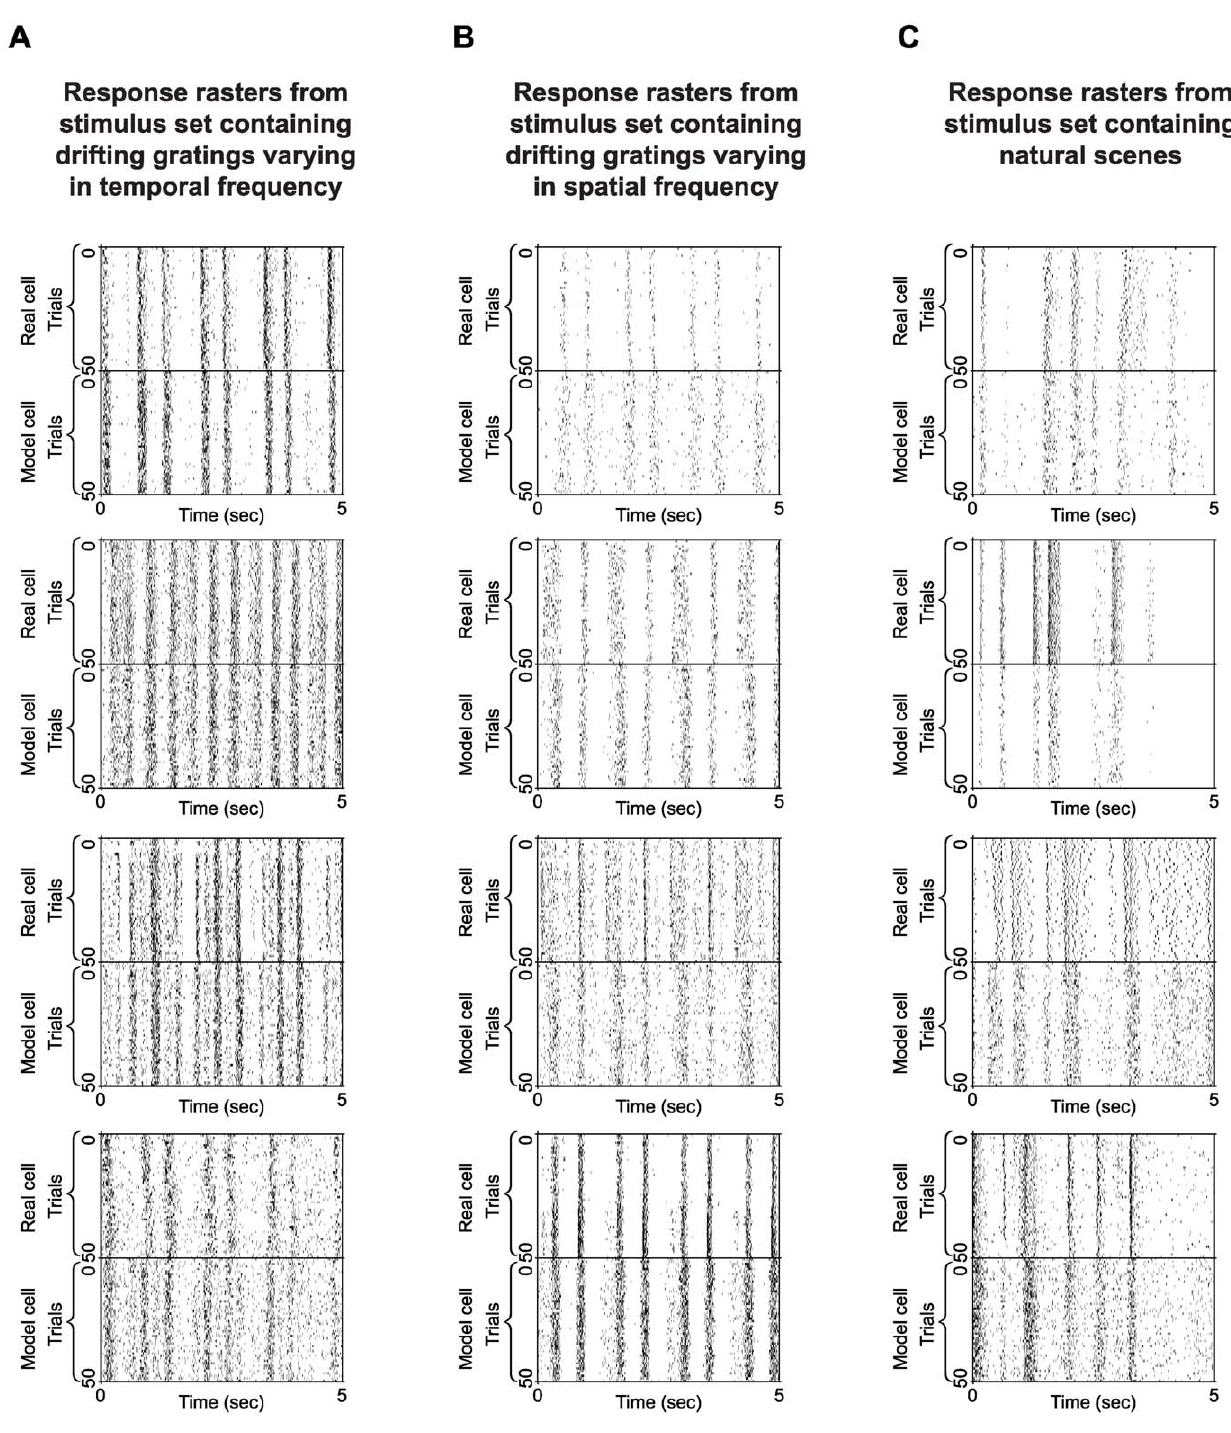
Figure 8. Response rasters for the first 12 cells shown in Fig. 4. Fig. 4 shows real and model cell performance using three sets of stimuli. Here we show rasters of the underlying responses. A . Rasters for the responses to the drifting gratings that varied in temporal frequency. The stimulus is a continuous stream of drifting gratings with uniform gray fields interleaved (grating stimuli are 1 s; gray fields are 0.33 s). 5 s of a 41 s stimulus are shown (repeated 50 times). Note that each cell is viewing a different location in the movie. B . Rasters for the responses to the drifting gratings that varied in spatial frequency. As above, the stimulus is a continuous stream of drifting gratings with uniform gray fields interleaved (grating stimuli are 1 s, gray fields are 0.33 s). Each cell is viewing a different location of the stimulus. C. Rasters for the responses to the natural scene movies. The stimulus is a continuous stream of natural movies with uniform gray fields interleaved (natural movie snippets are 1 s long, gray fields are 0.33 s). Note again that each cell is viewing a different location in the movie: this is most notable in the rasters for the natural scene snippets, since these are not periodic stimuli.